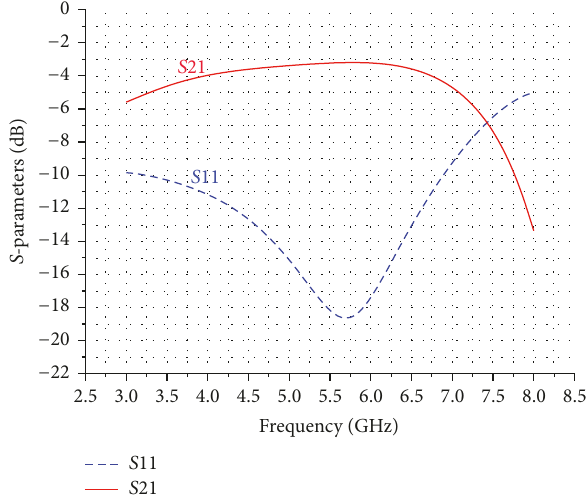
Figure 4: Simulated S -parameters of the 3dB CPW power